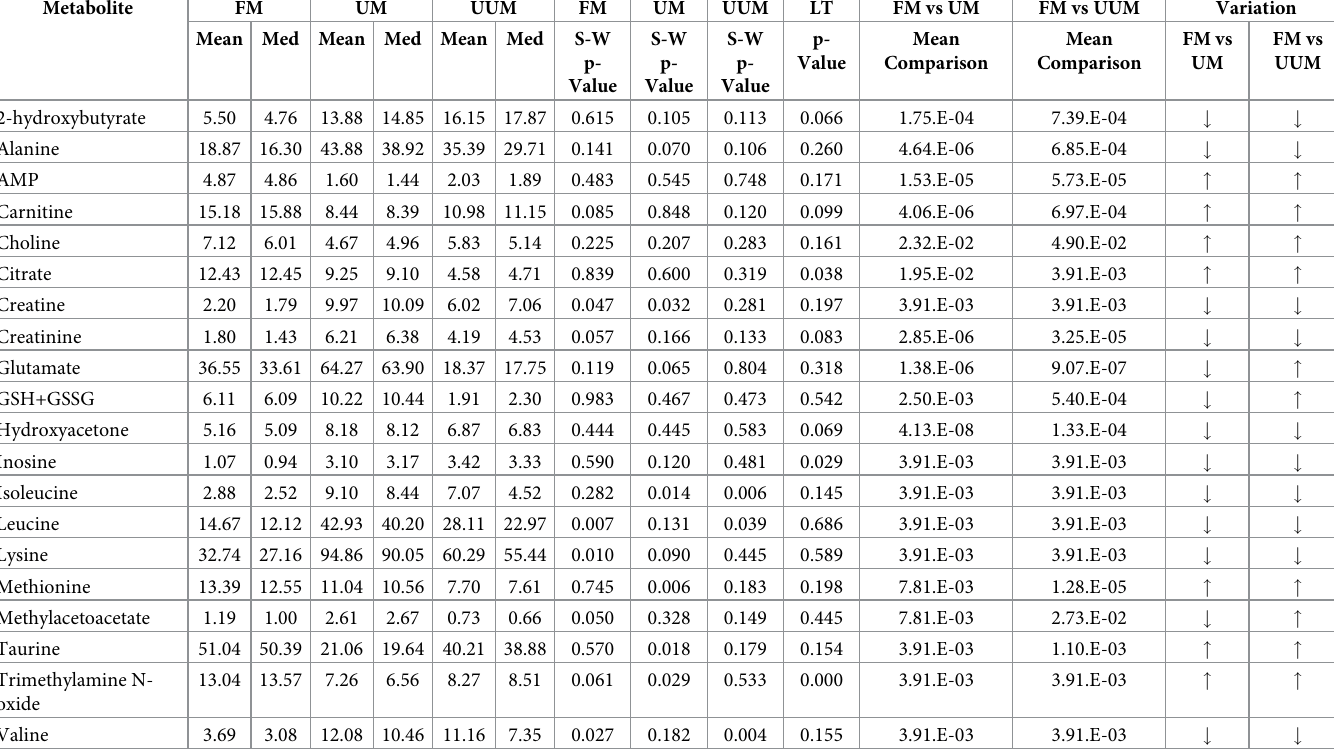
Table 2. Metabolites significant for the comparisons between FM vs. UM and FM vs. UUM.